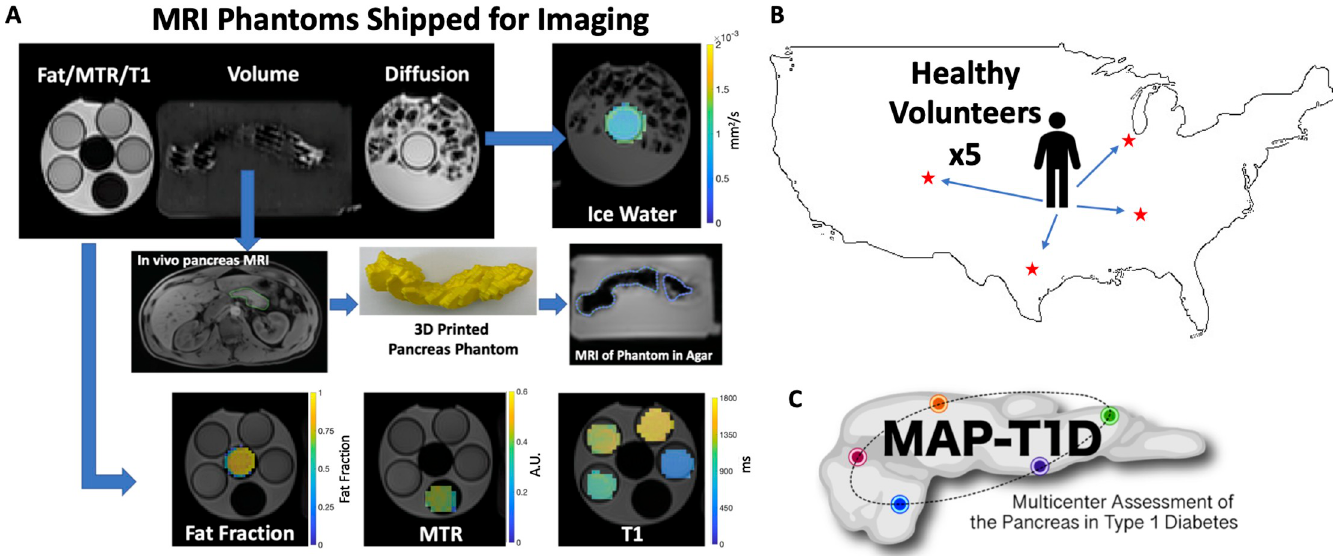
Fig 1. Schematic of MRI data acquisition. A) Example MRI of synthetic phantoms with calibrated properties that were shipped to five different sites for imaging. The phantom (upper left) consisted of three components. The leftmost bottle contained phantoms with canola oil, bovine serum albumin, and gadolinium-doped gelatin to validate fat fraction, MTR, and T1 measurements, respectively. Example fat fraction, MTR, and T1 maps are shown on the bottom row. The middle bottle contained a 3D printed pancreas created from an MRI of a normal volunteer pancreas and subsequently embedded in agar for imaging (middle row). The rightmost bottle contained deionized water chilled to 0˚C to validate diffusion-weighted MRI measurements. B) Five healthy volunteers traveled to four sites in the US (Austin, Chicago, Denver, and Nashville) for an MRI of the pancreas using the harmonized acquisition protocol. C) MAP-T1D study logo.